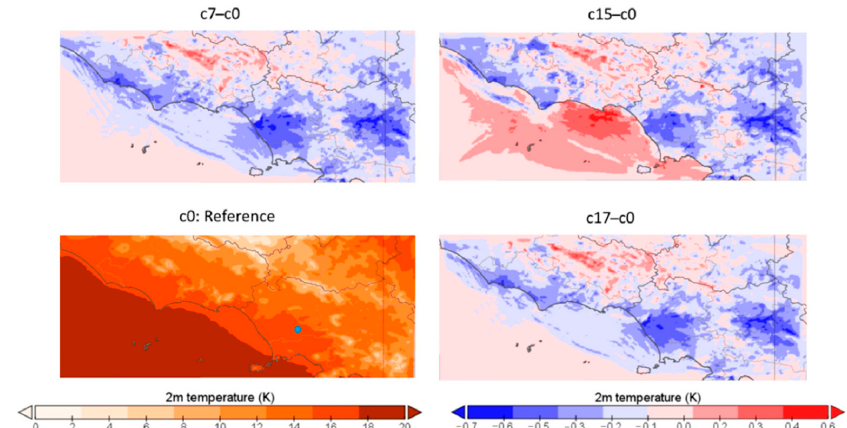
Figure 5. T2m distribution ( ◦ C) related to 3 November (mean value) for configuration c0 (reference) and di ff erence of distributions obtained with configurations c7, c15, and c17 compared to the reference one. The CIRA site is identified by a blue